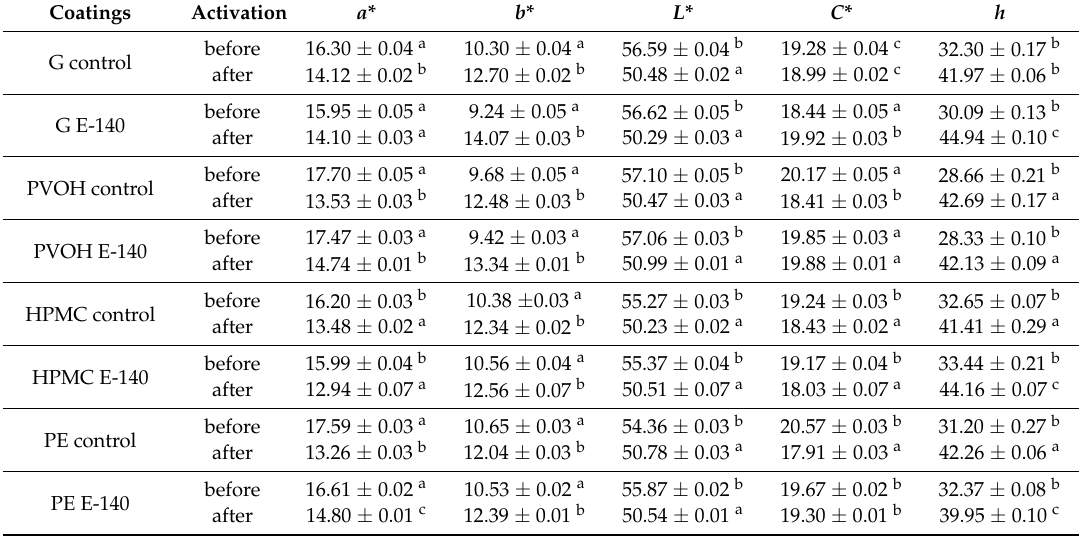
Table 6. The color coordinates L *, a *, b *, the chromaticity ( C *), and the tone ( h in ◦ ) of bologna slices covered with G, PVOH, PE, and HPMC coatings on PET before and after